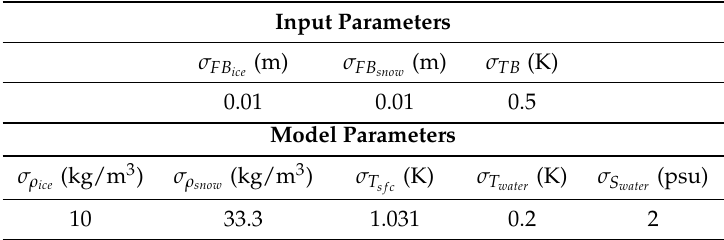
Table 3. The uncertainty ( σ ) of input parameters and model parameters in sensitivity